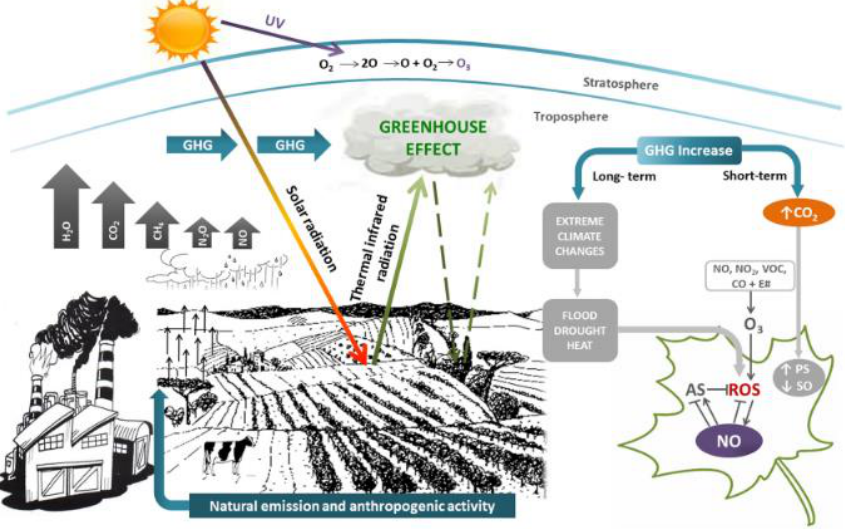
Figure 4. The Greenhouse Effect explained. Reprinted from ref. [24] .